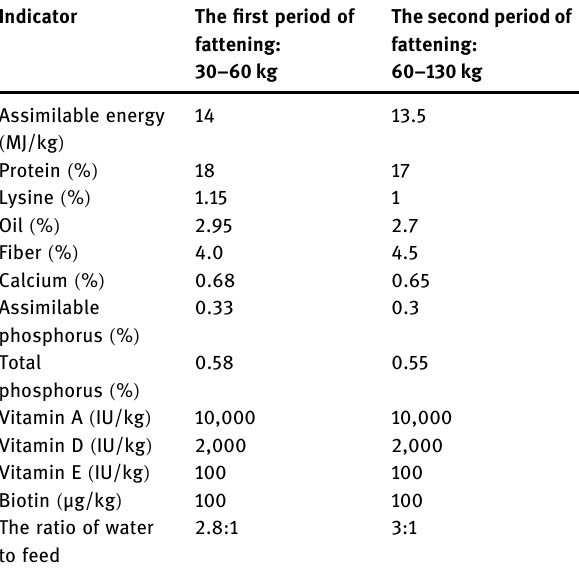
Table 1: Nutritional value of feed for the fi rst and second stages of fattening